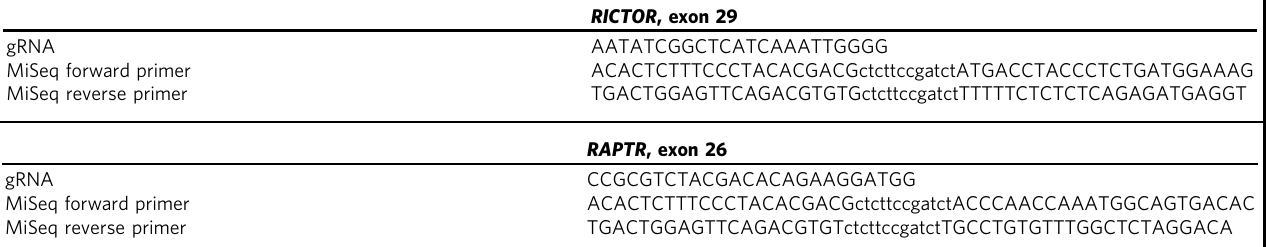
Table 1 Guide RNAs and primer sequences used for CRISPR-Cas9 gene